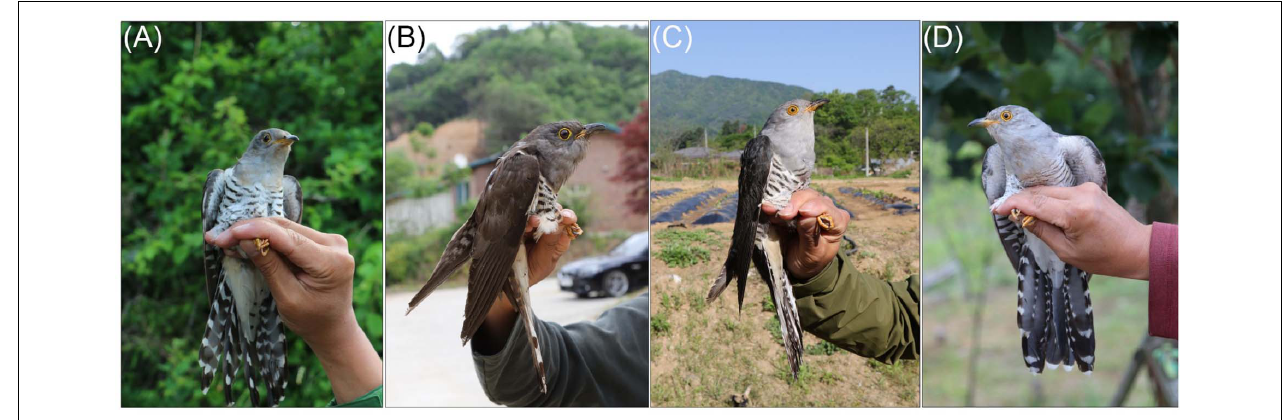
FIGURE 1 | Photographs of the four Cuculus cuckoos: (A) male lesser cuckoo, C. poliocephalus , (B) male Indian cuckoo, C. micropterus , (C) male oriental cuckoo, C. optatus , (D) male common cuckoo, C. canorus . ©All photos, J-W Lee. TABLE 1 | Mean ( ± s.d.) body size, number of inner wing spots, and thickness of underpart barring of the four Cuculus male cuckoos. Lesser cuckoo Indian cuckoo Oriental cuckoo